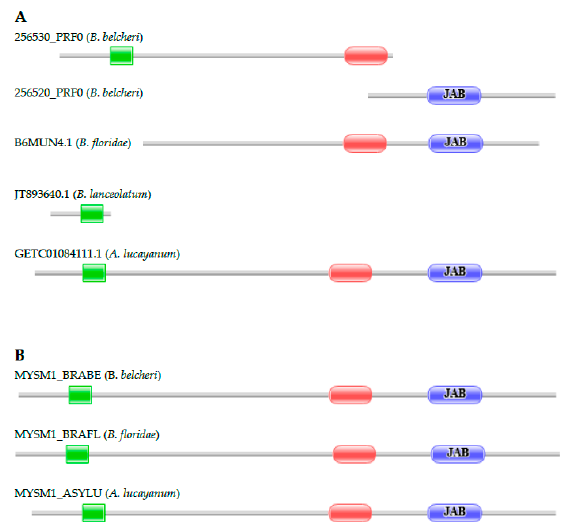
Figure 4. Myb Like, SWIRM And MPN Domains 1 (MYSM1) genes encoding proteins with domain